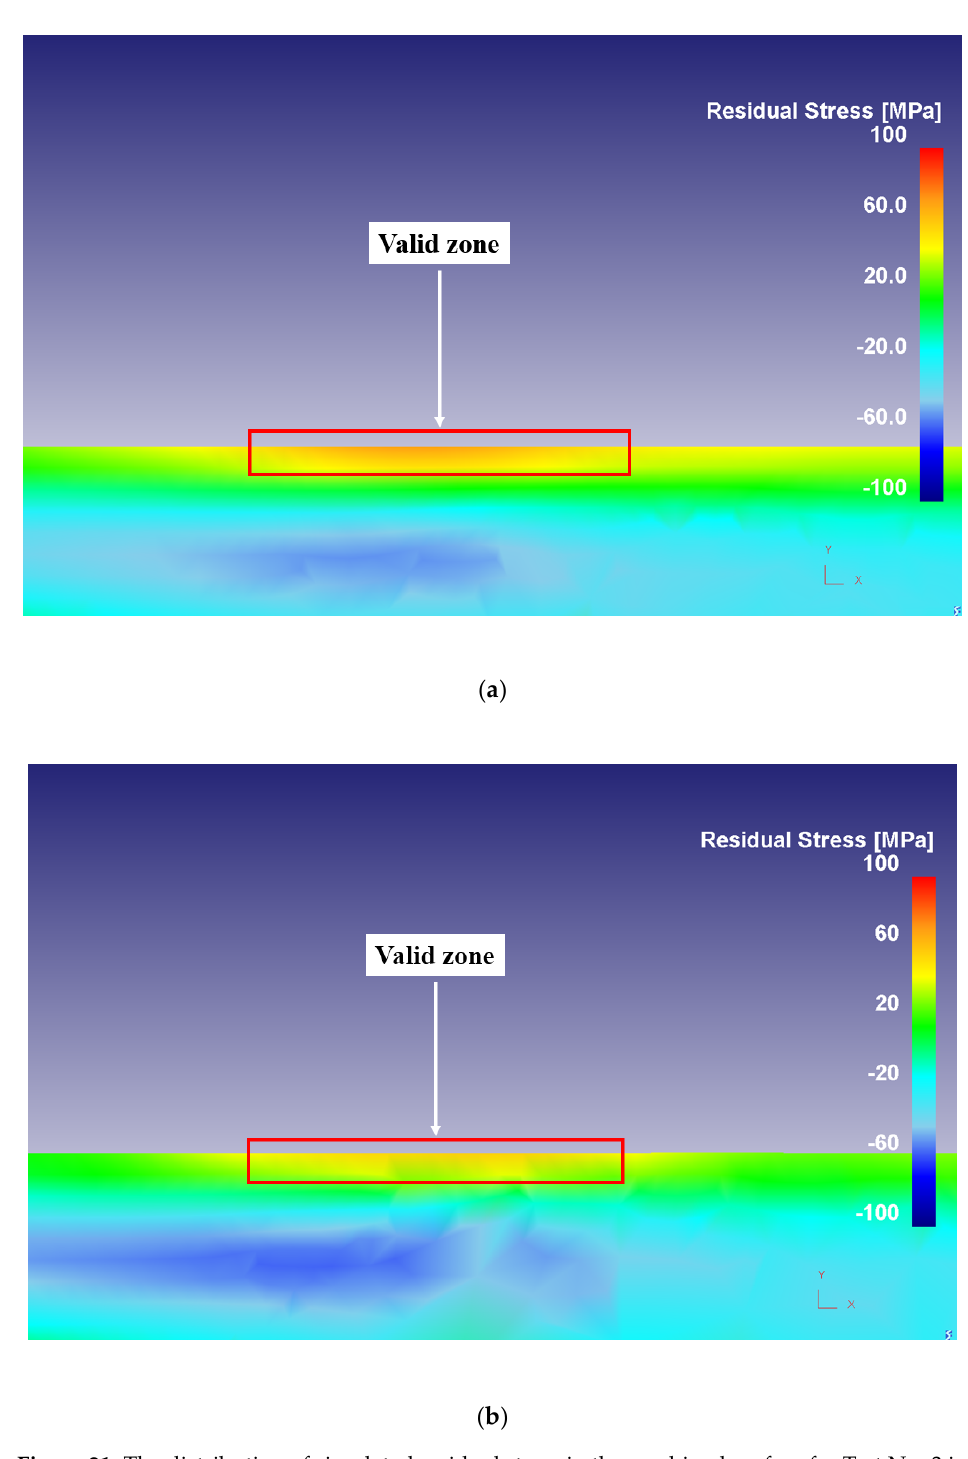
Figure 21. The distribution of simulated residual stress in the machined surface for Test No. 3 in ( a ) dry and ( b ) flood-coolant